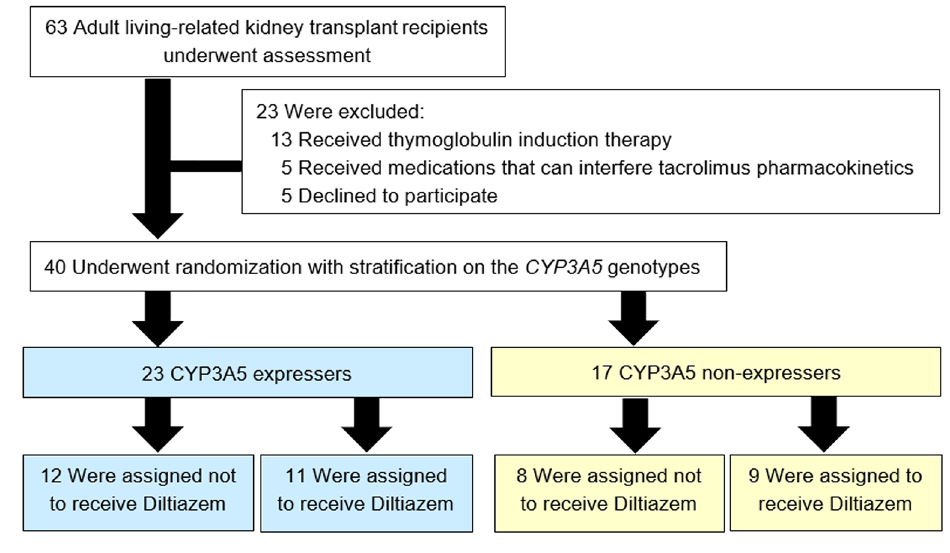
Figure 1. Flow diagram of patient